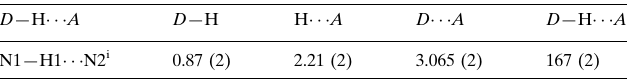
Hydrogen-bond geometry (A˚ , (cid:1)